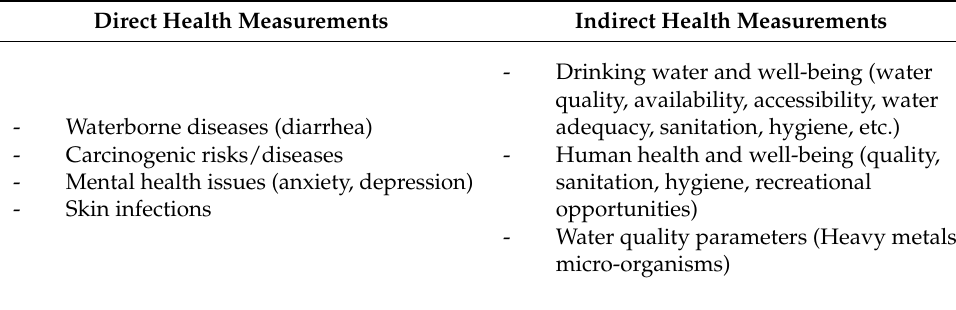
Table 1. Public health measurement in water